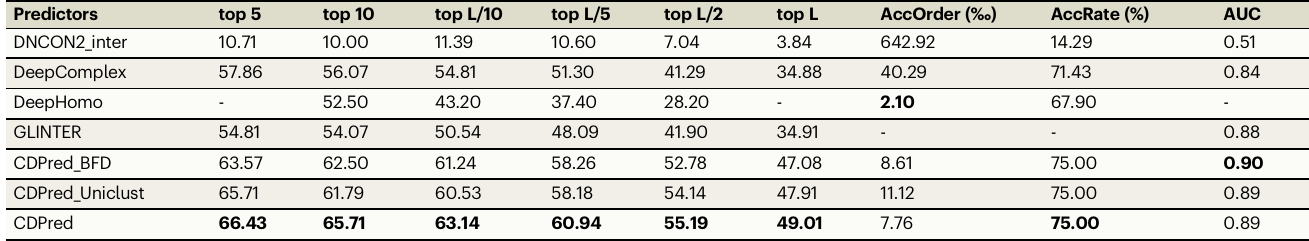
DNCON2_inter, DeepComplex, DeepHomo, GLINTER, and three versions of